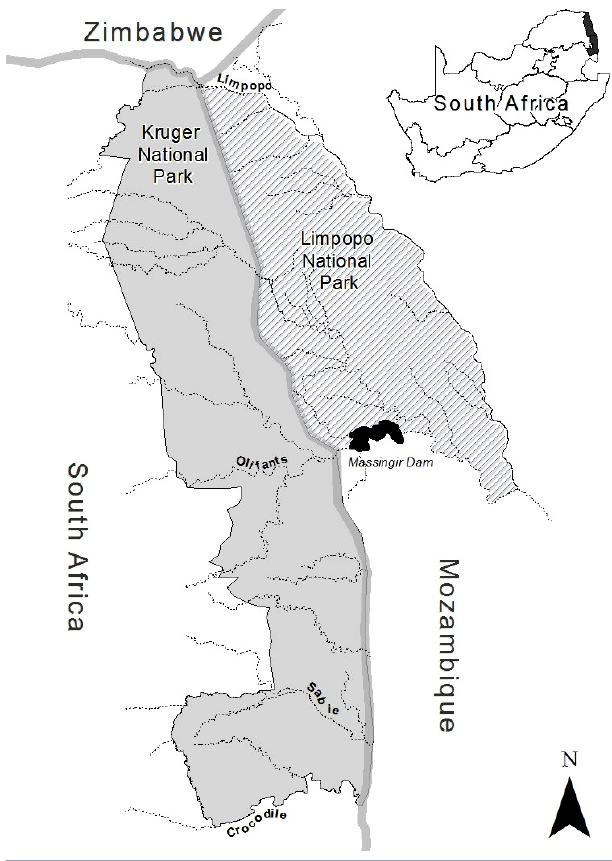
Fig. 1 . Locality map of Kruger National Park in northeastern South Africa, showing its transfrontier context as well as key geographic features that influenced decision making in the